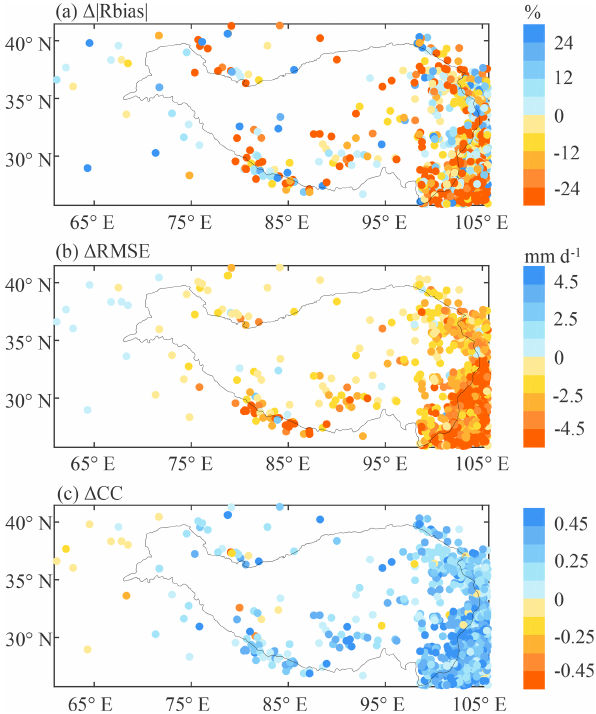
Figure 5. Spatial distribution of error metric differences between ERA5_CNN and TPHiPr. The differences are calculated by sub- tracting the metrics of ERA5_CNN from those of